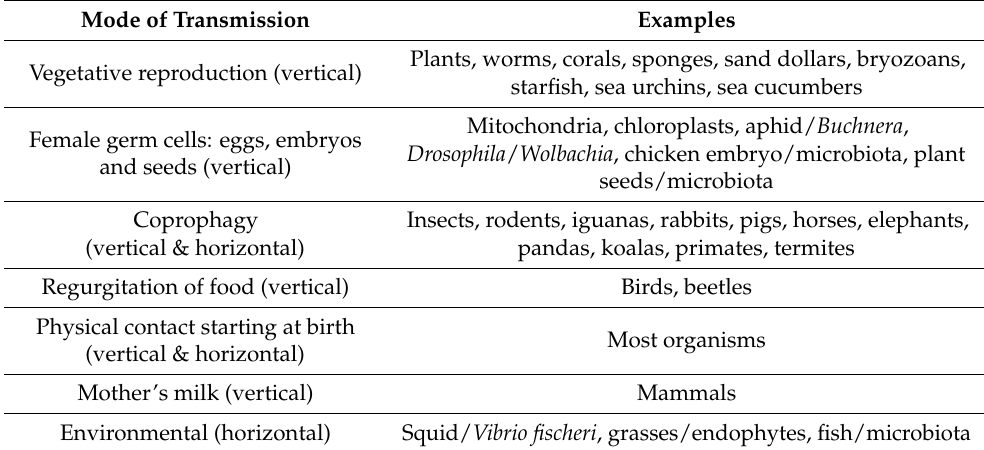
Table 1. Modes of transmission of